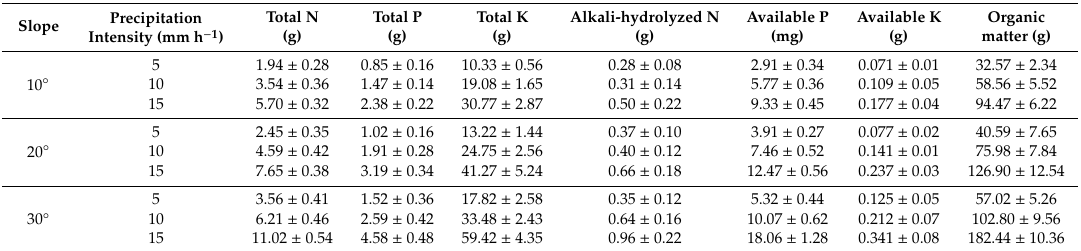
Table 2. Soil nutrient loss with slope gradient and precipitation intensity. Slope